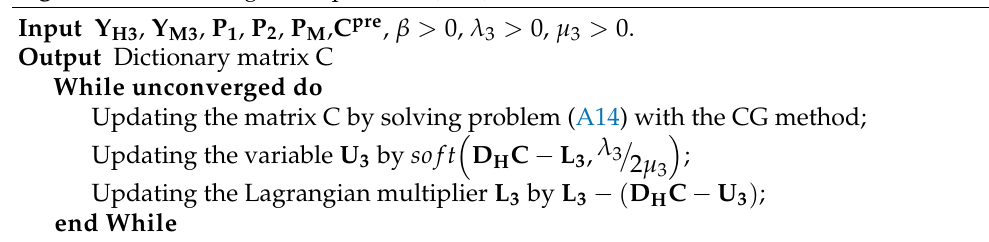
Algorithm A2 Solving C-Subproblem (A12) via